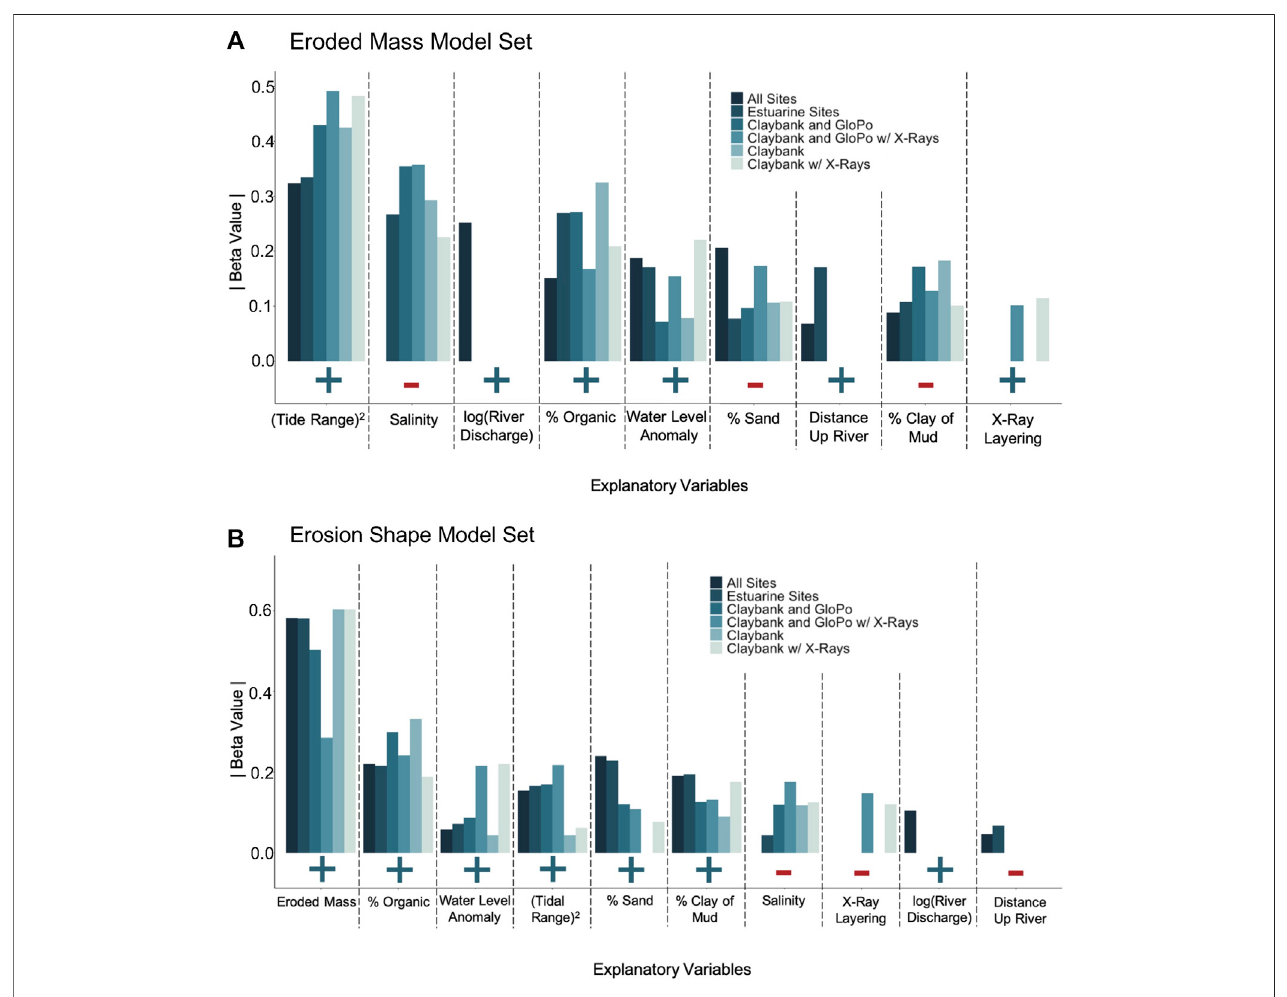
FIGURE 7 | Bar graphs showing average absolute β values for each explanatory variable for each data subset (corresponding colors) that were included in candidate models. Signs below bar graphs indicate whether the β value was positive (blue “ + ” = direct relationship) or negative (red “ − ” = inverse relationship). Absent lines indicate parameters that were not considered in the model or parameters that were not present in any of the candidate models.